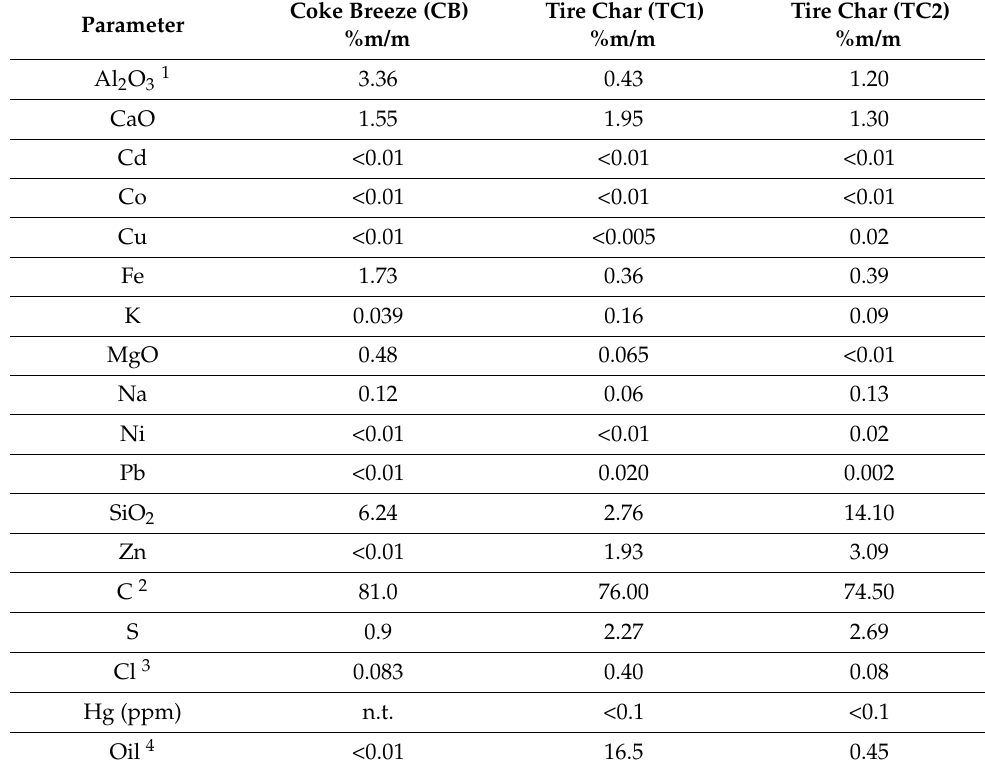
Table 2. Chemical analysis of tested